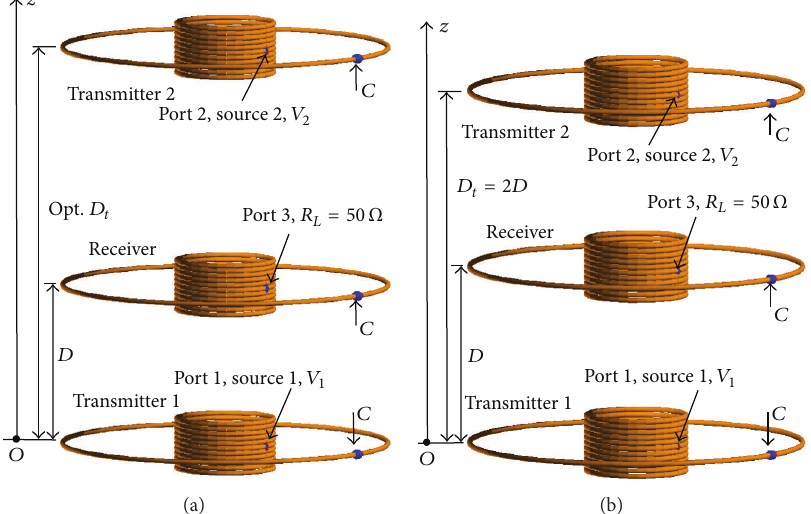
Figure 19: Integrated utilization of the proposed methods for WPT. (a) WPT system with two transmitters based on the optimum 𝐷 𝑡 of retriever-based system. (b) WPT system with 𝐷 𝑡 = 2𝐷 , phase 2 − phase 1 = 0, and 𝑉 2 /𝑉 1 = 1.